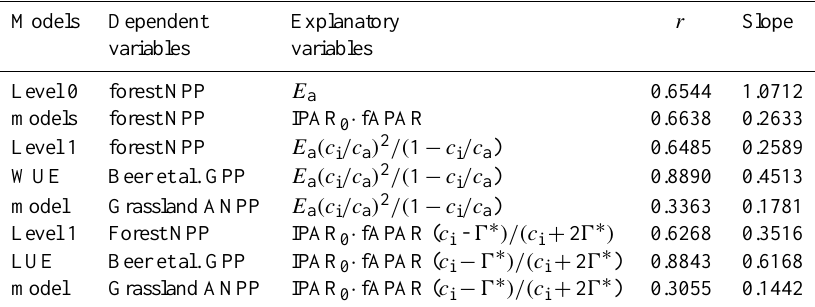
Table 1. Fitted linear regression models with dependent variables, explanatory variables, correlation coefficients ( r ) and regression slopes (without